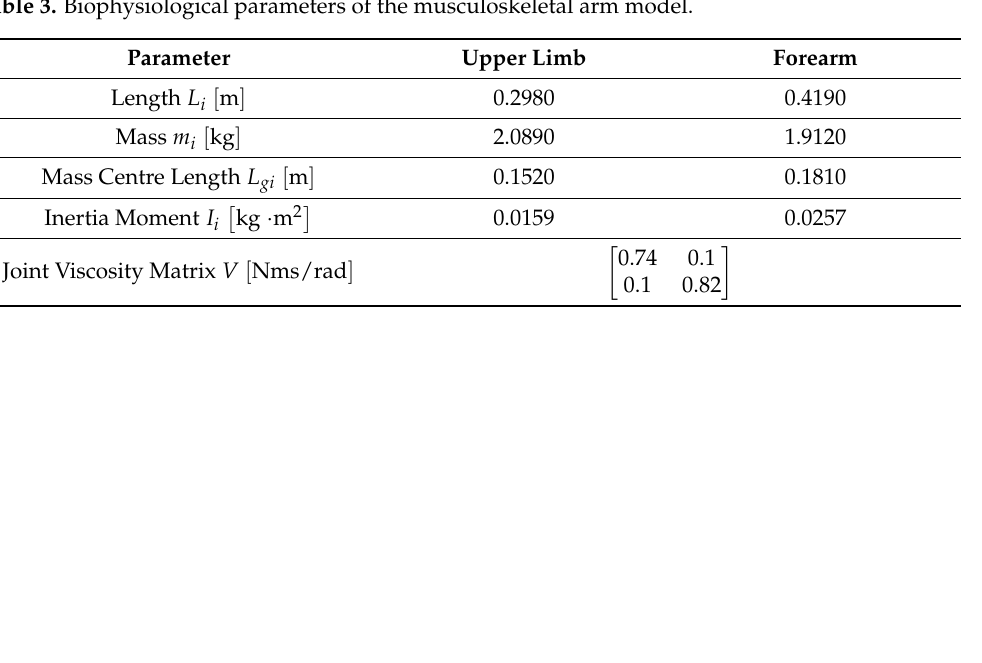
Table 4. Biophysiological parameters of skeletal muscles.